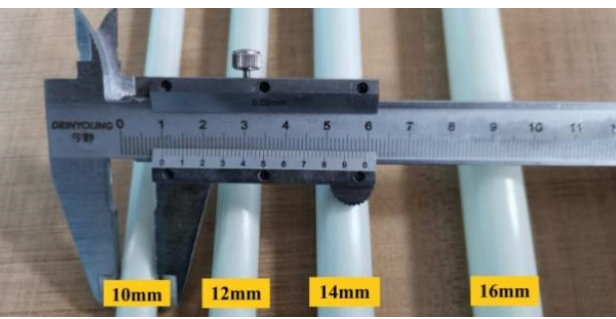
Figure 4. Hollow connecting rods with different outer diameters (Unit: mm).